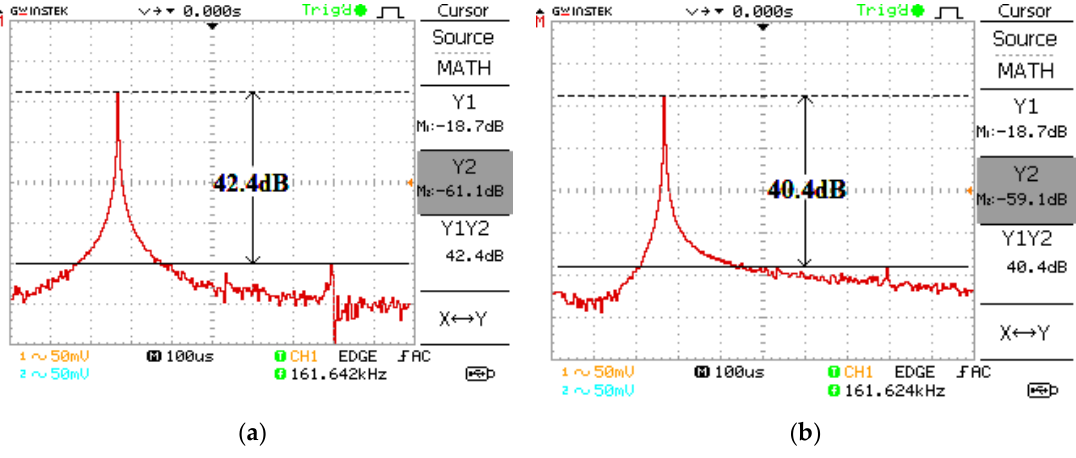
Figure 8. Measured spectrum for ( a ) v o1 and ( b ) v o2 .